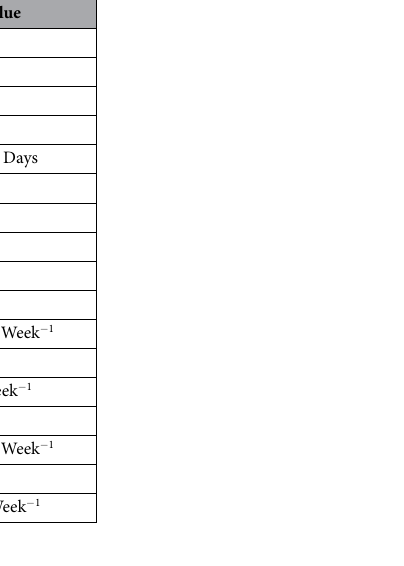
Table 3. CLIMEX parameter values for ESC and